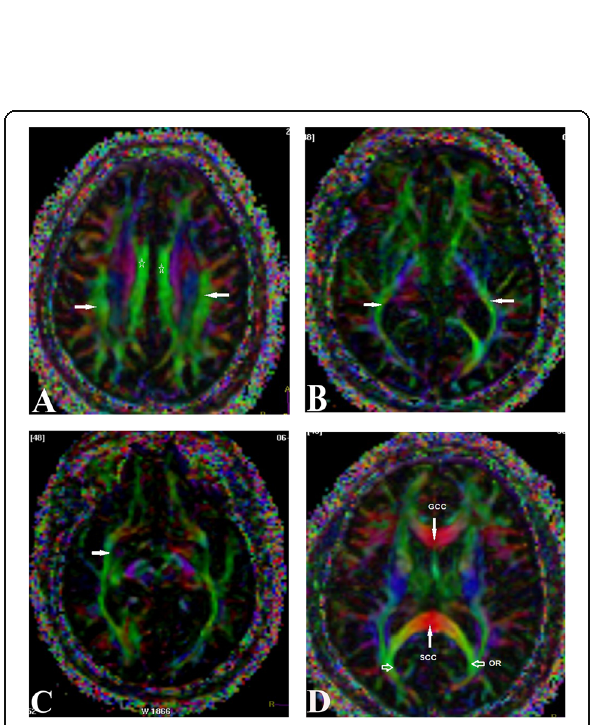
Fig. 2 Identification of selected white matter tracts: a paired cingula just cephalad to corpus callosum (star), superior longitudinal fasciculus (white arrow), b inferior occipitofrontal fasciculus (white arrow), c Uncinate fasciculus (white arrow), d Genu and splenium of corpus callosum (GCC,SCC), optic radiation (open arrow)